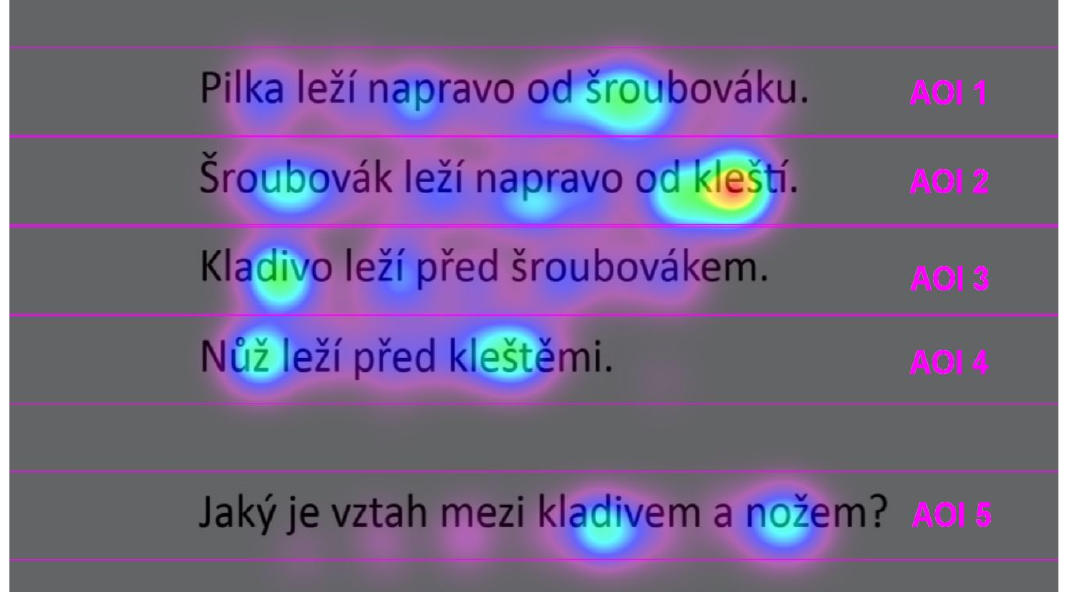
Figure 2. The layout of the screen during the presentation of an experimental trial, with overlaid AOIs and heatmap of the par- ticipant #30. Warmer colors indicate greater attention paid to the underlying area on the screen, as derived from the number and duration of gaze fixations. The translation of the utterances used in this example is as follows: 1. The handsaw lies to the right of the screwdriver. 2. The screwdriver lies to the right of the pliers. 3. The hammer lies in front of the screwdriver. 4. The knife lies in front of the pliers. 5. What is the relation between the hammer and the